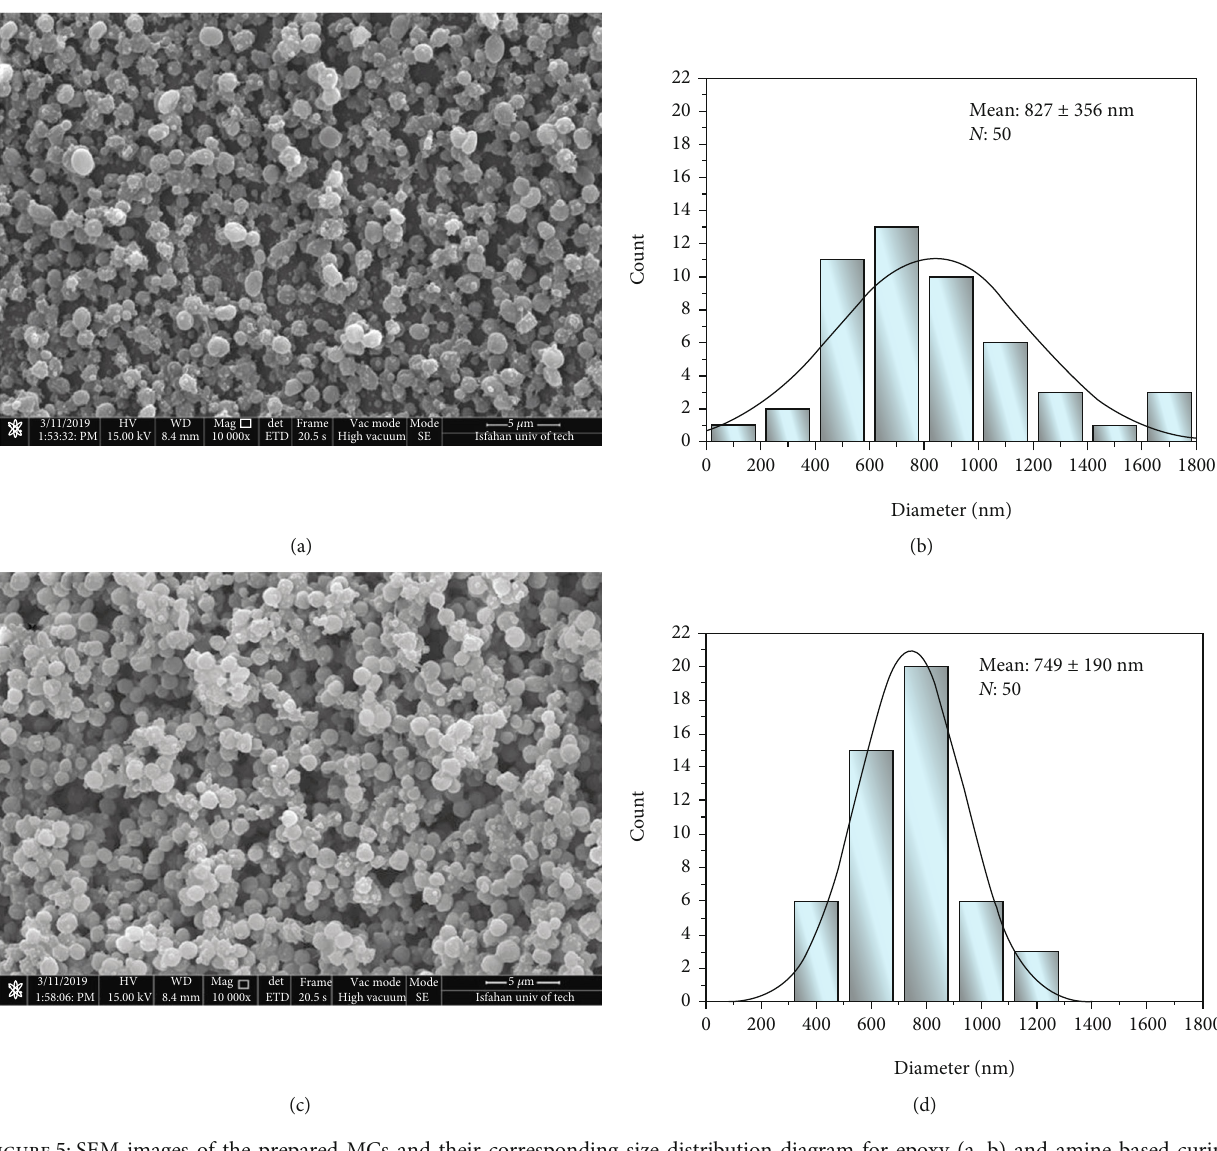
Figure 5: SEM images of the prepared MCs and their corresponding size distribution diagram for epoxy (a, b) and amine-based curing agent (c, d)